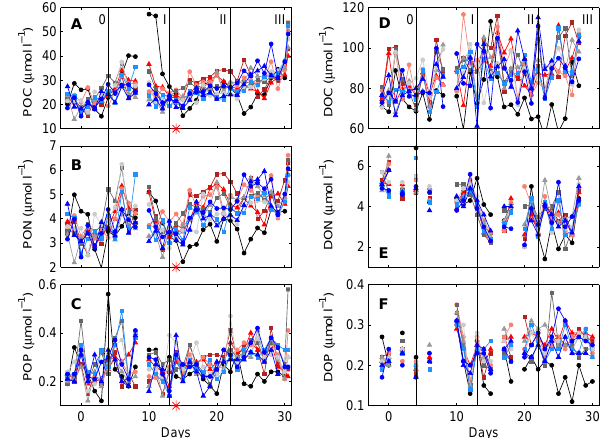
Fig. 8. Temporal development of depth-averaged (0.3–12m) partic- ulate organic carbon (A) , nitrogen (B) and phosphorus (C) , together with dissolved organic carbon (D) , nitrogen (E) and phosphorus (F) concentrations. Style and colour code follow those of Fig. 6, and statistical results are summarized in Table